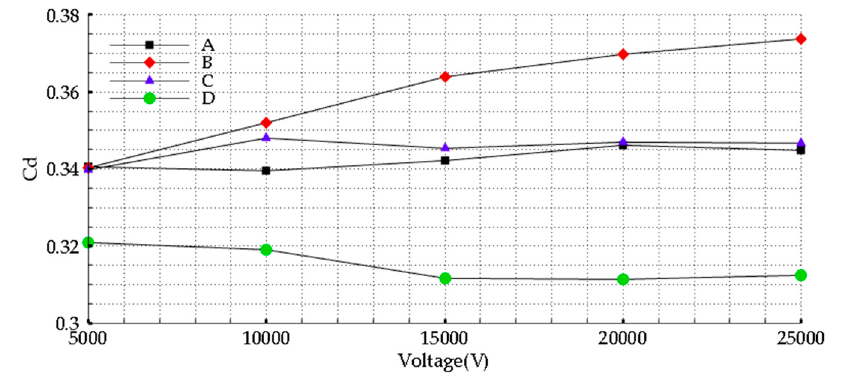
Figure 11. The influence of different positions and voltages on the drag coefficient.